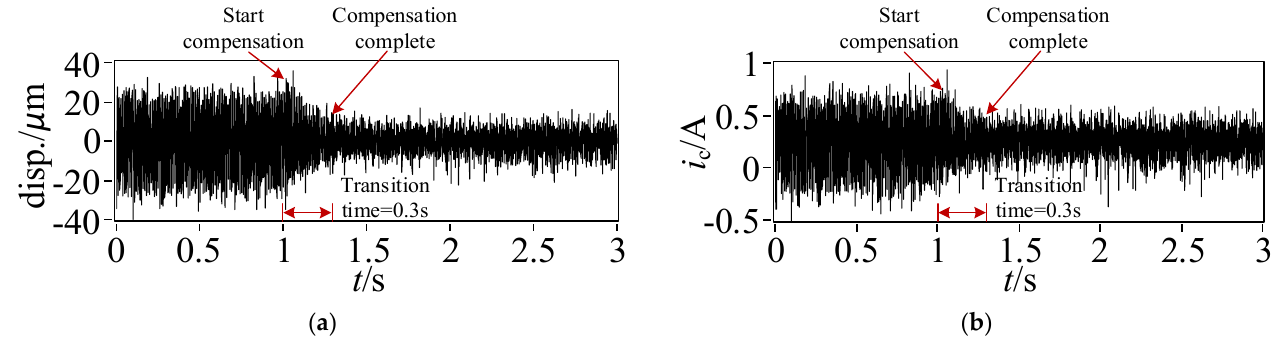
Figure 8. LMS compensation process. ( a ) displacement diagram; ( b ) current graph.